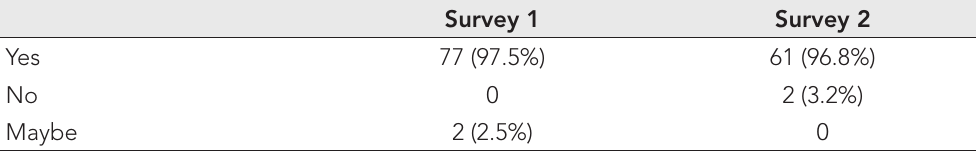
Table 1: Should Australia provide global development